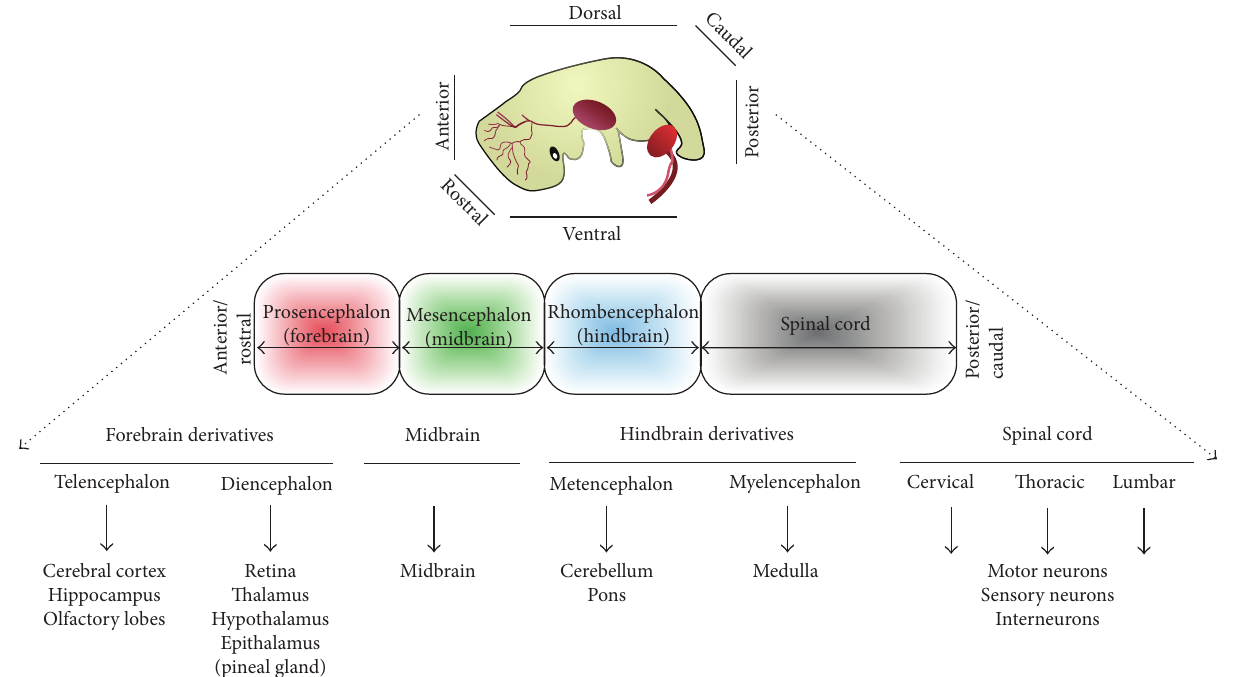
Figure 1: A simplified depiction of vertebrate nervous system regional organization (image of fetus adapted from [4]).